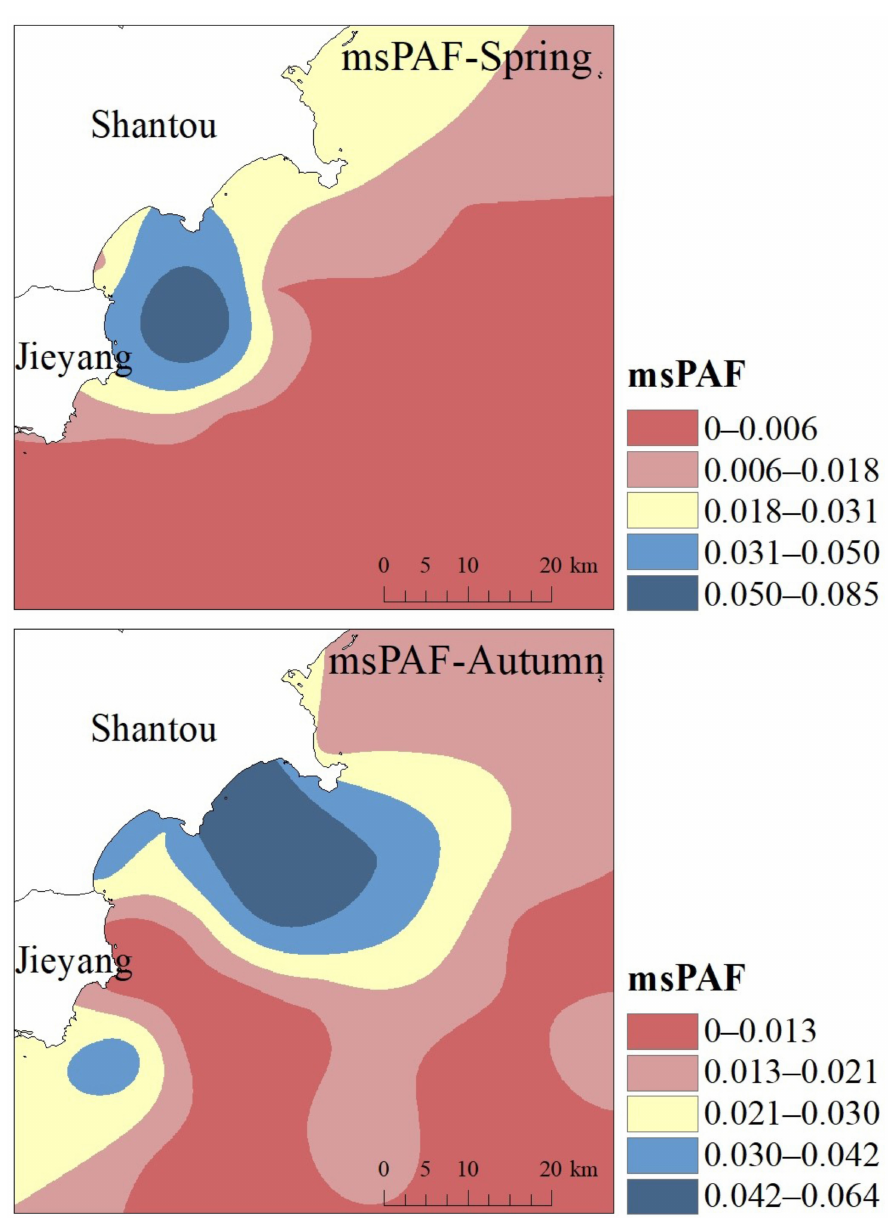
Figure 7. Compound hazard ratio (msPAF) of heavy metals in the seawater of